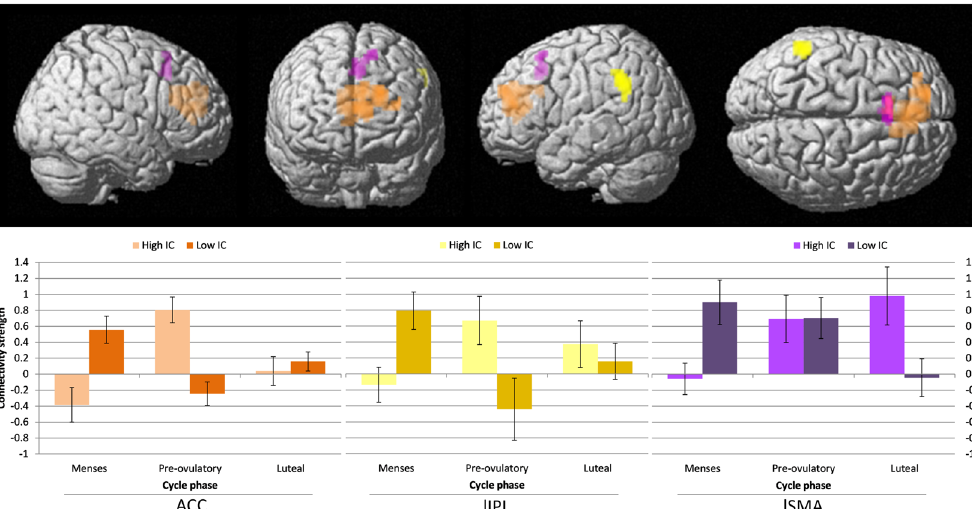
Figure 5. Interactive effect of cycle phase and baseline inhibitory control (IC) on connectivity strength from the left putamen during inhibited responses compared to non-inhibited: During pre-ovulatory phase compared to menses connectivity strength between the left putamen and anterior cingulate cortex (ACC, in orange) and left inferior parietal lobe (lIPL, in yellow) was significantly higher for women with higher baseline IC, while it was decreased for women with lower baseline IC. During luteal phase compared to menses connectivity strength between the left putamen and left supplementary motor area (lSMA, in purple) was significantly higher for women with higher baseline IC, while it was decreased for women with lower baseline IC. Uncorrected p < 0.001, pFWE < 0.05 at cluster level, and extent threshold of k = 40 voxels. Baseline IC as a covariate of interest was used as a continuous variable, but the sample is split by the median for displaying purposes. Error bars represent standard